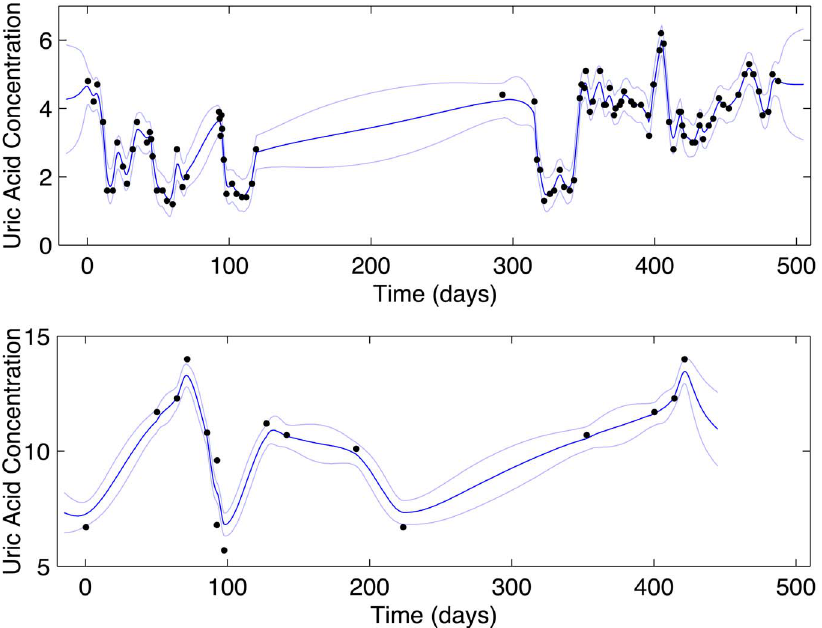
Figure 1. Gaussian process regression transforms noisy, irregular, and sparse observations to a longitudinal probability distribution. A cross section at any point in time in these plots is a proper Gaussian probability density centered at posterior mean m i with standard deviation s i . The top panel is a selected leukemia sequence, the bottom panel a selected gout sequence. Black dots: observed values. Dark blue line: posterior mean m i . Light blue lines: standard deviation s i .